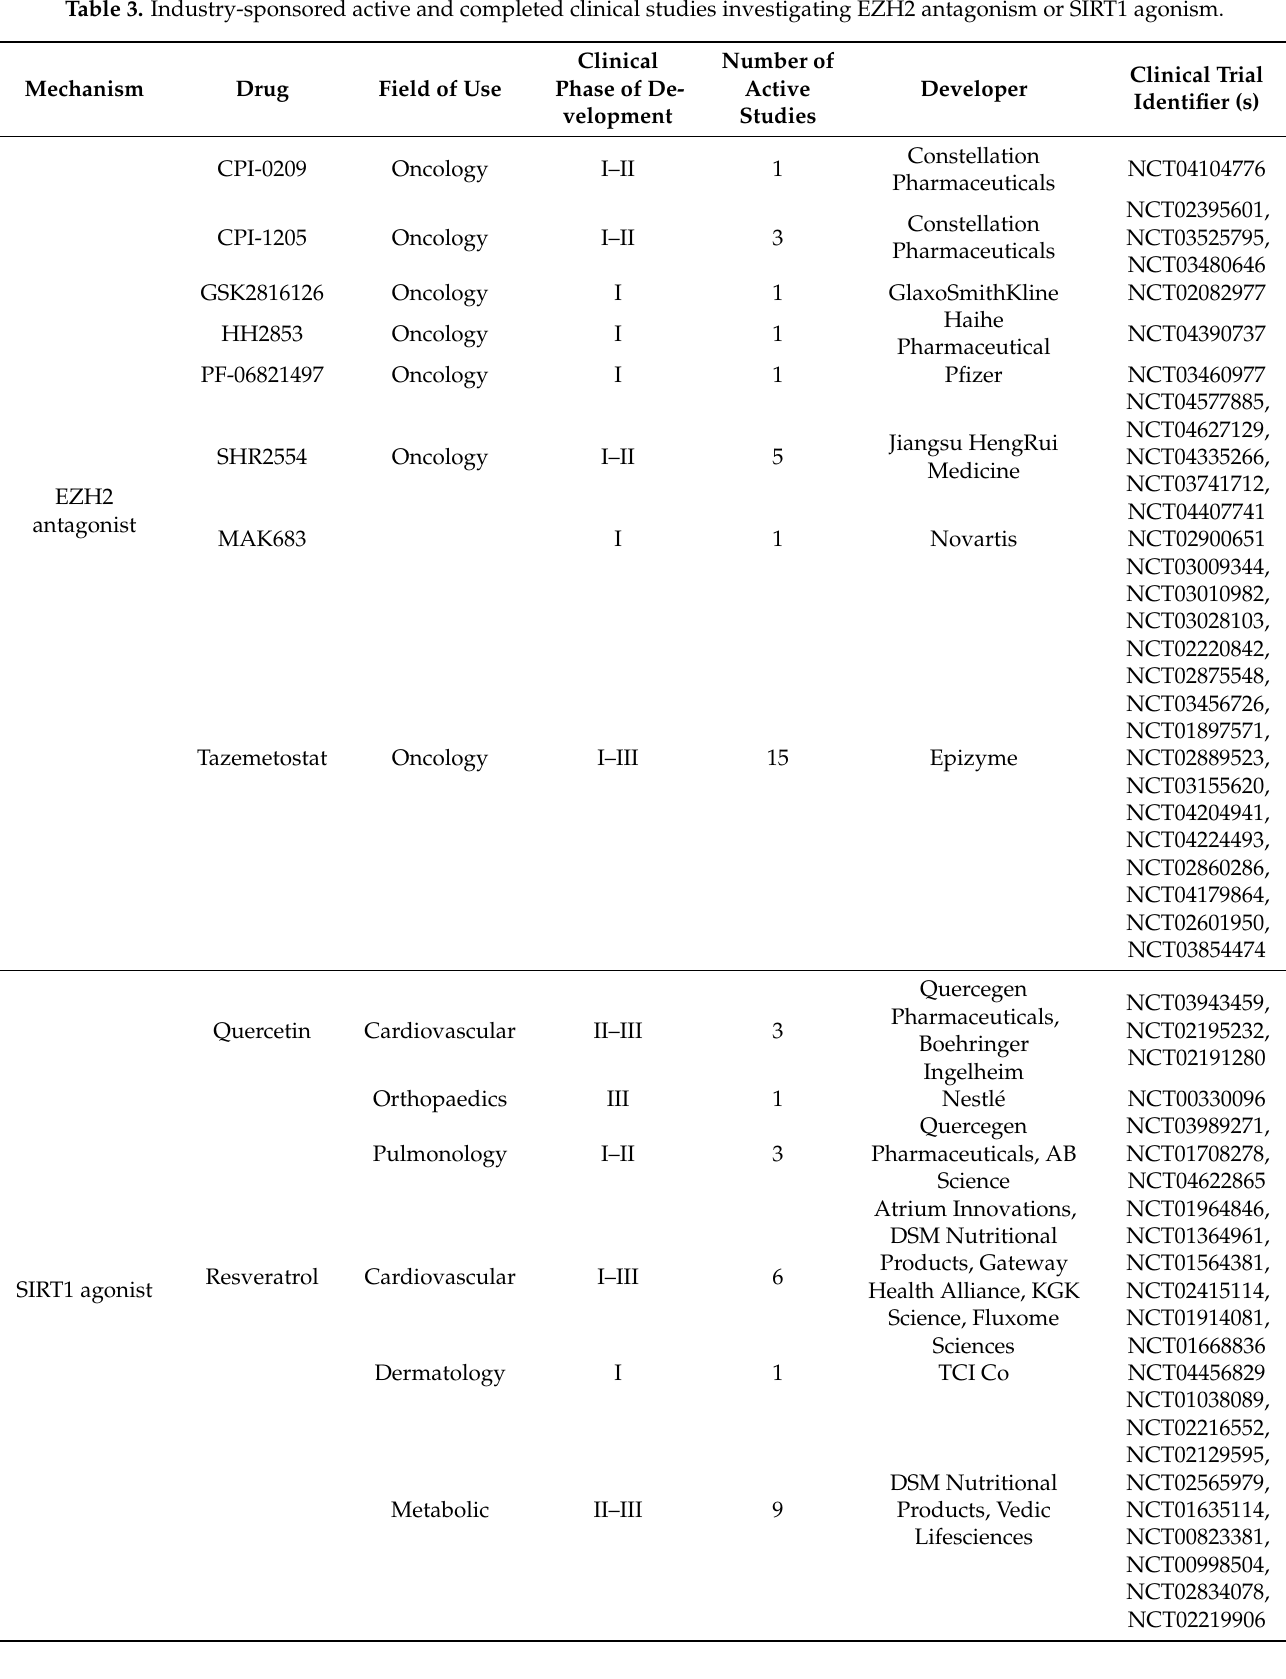
Table 3. Industry-sponsored active and completed clinical studies investigating EZH2 antagonism or SIRT1 agonism.